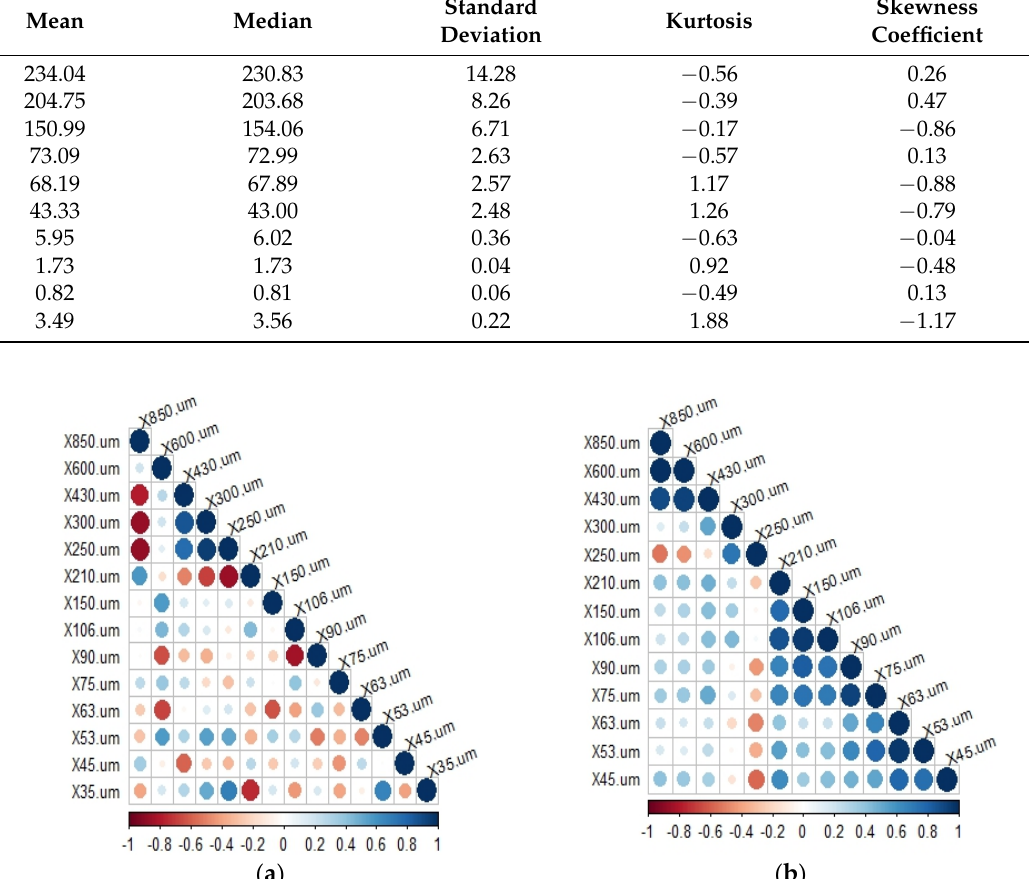
Figure A5. Cross-correlation analysis for 8 min grinding: ( a ) WPES; and ( b ) PSD.